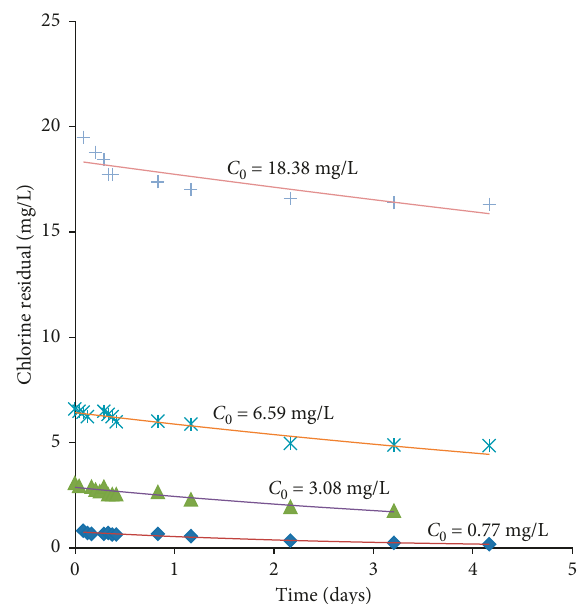
Figure 5: Variation of residual chlorine under different initial chlorine doses